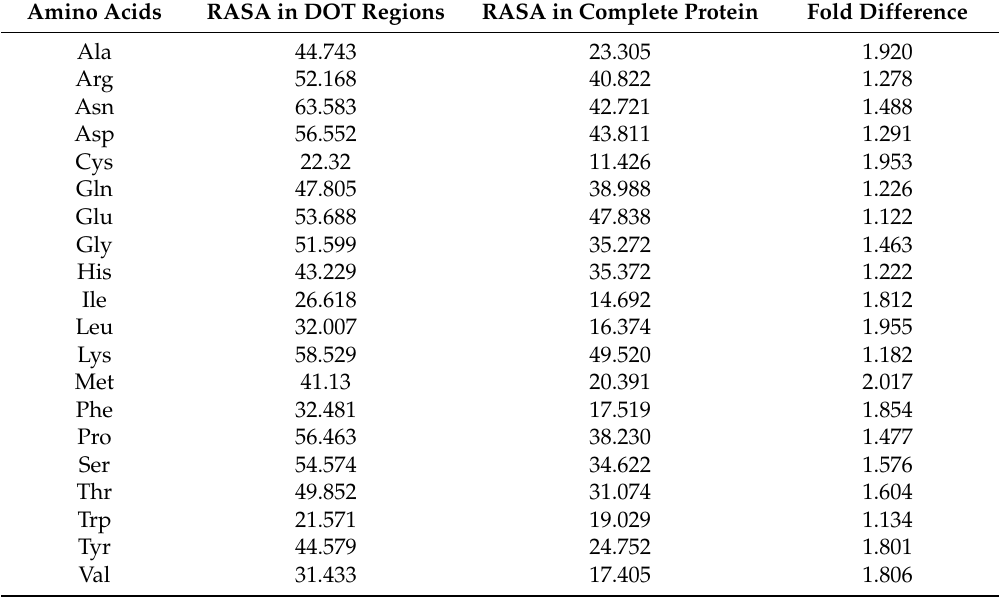
Table 2. Relative average solvent accessibility (RASA) of DOT residues and all residues in non-ribosomal protein–RNA